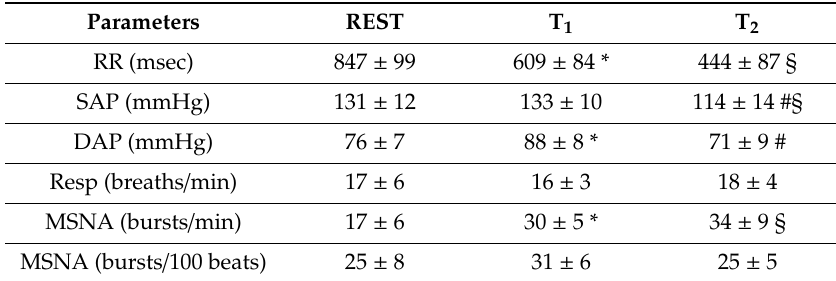
Table 1. Hemodynamic parameters, respiratory activity and sympathetic post-ganglionic discharge activity (MSNA) while supine (REST), during the asymptomatic phase of tilt (T 1 ) and the period of tilt just preceding syncope (T 2 ). Values are expressed as mean ± standard deviation.